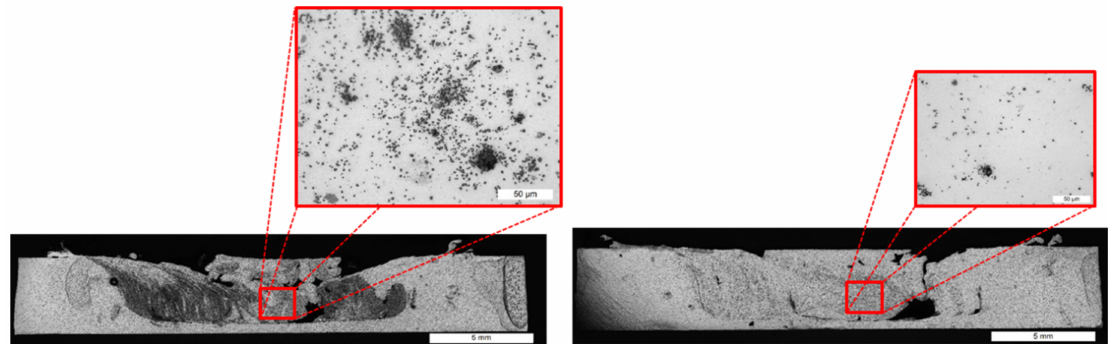
Figure 9. Tungsten carbide in the welding seam, removal after 10 mm ( left ), removal after 50 mm ( right ).